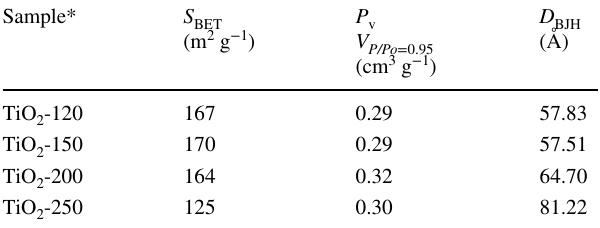
*All samples were thermally treated at 200 °C for